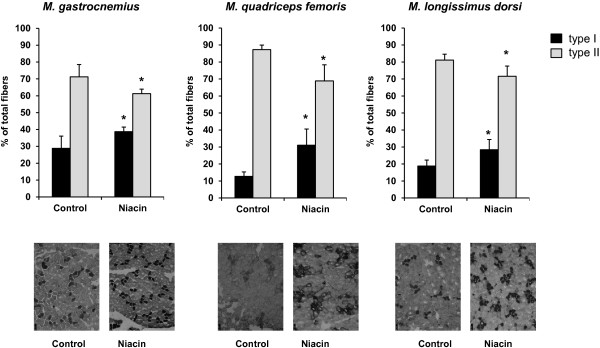
Muscle fiber type distribution of M. gastrocnemius, M. quadriceps femoris and M. longissimus dorsi of pigs fed either a control diet or a diet supplemented with 750 mg niacin/kg diet for 3 wk. Bars represent means ± SD, n = 12 (control) and 13 (niacin) pigs/group. Images from cross sections representing one animal per group are shown at the bottom. Asterisk denotes difference from control group, P < 0.05.